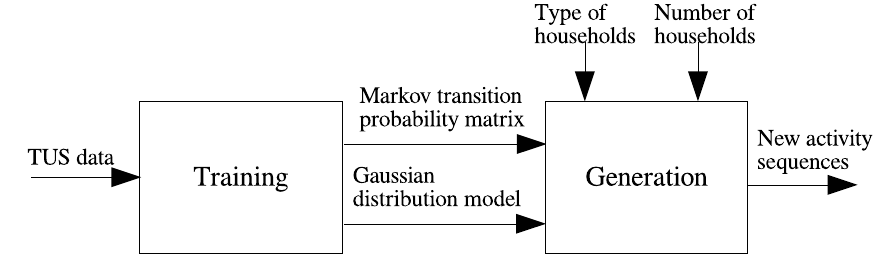
Figure 1. Overview of residential user activity